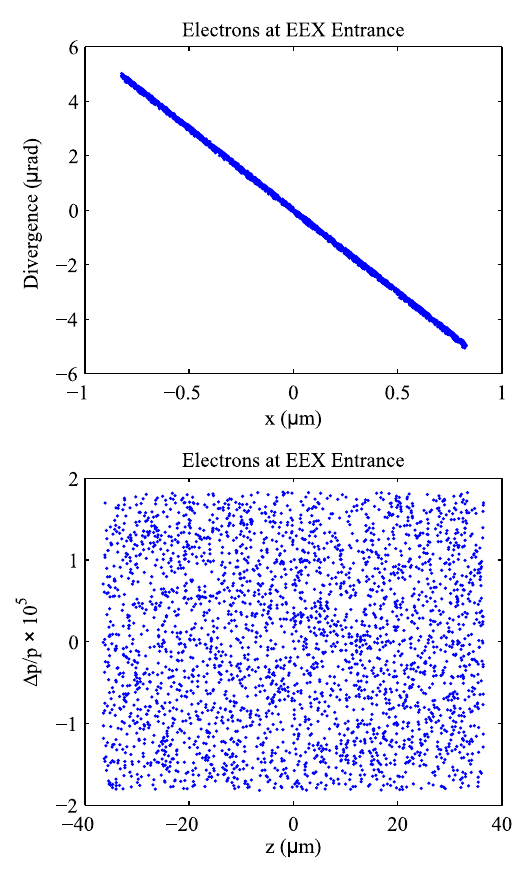
FIG. 3. The phase space of the input electron bunch in the (top) transverse and (bottom) longitudinal dimension. The input param- eterswereselectedtoproduceabeamwithnoenergychirpattheexit.